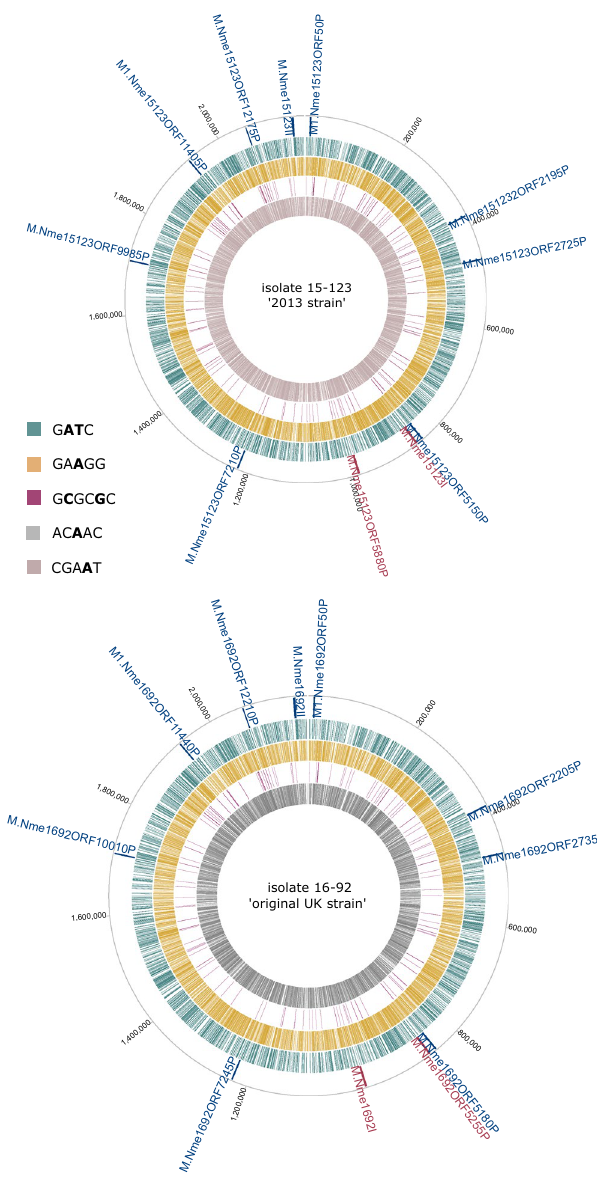
Figure 2. Distribution of methylated bases in two N. meningitidis serogroup W isolates from the 2013 strain (top) and original UK strain (bottom), respectively. The relative positions of predicted methyltransferases are indicated on the outermost track: Type II, blue; Type III, maroon. The remaining coloured tracks display the location of methylated sites for each motif. From outer to inner: 5 ′ -G AT C-3 ′ , green; 5 ′ -GA A GG-3 ′ , yellow; 5 ′ -G C GC G C-3 ′ purple; 5 ′ -AC A CC-3 ′ , grey; 5 ′ -CGA A T-3 ′ , pink. Tick marks display the genomic